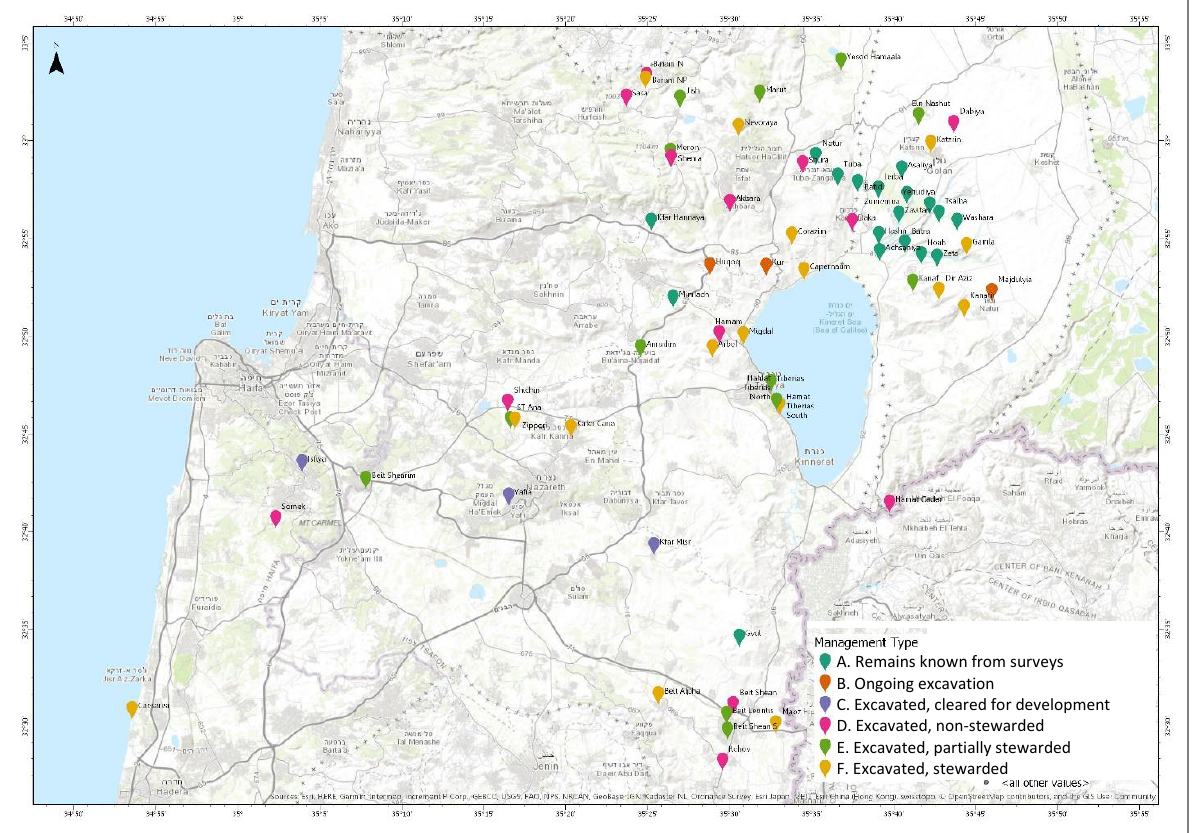
Figure 4. Map of the Synagogues classified by management